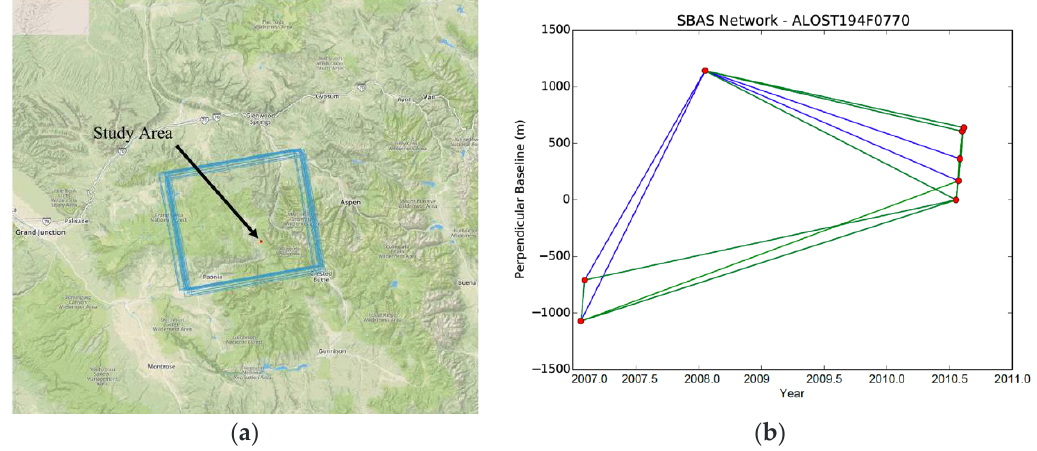
Figure 5. ( a ) Map of ascending ALOS-1 scene footprints used in SBAS analysis; ( b ) SBAS network with perpendicular baselines through Delaunay triangulation from the scenes listed in Table 1.